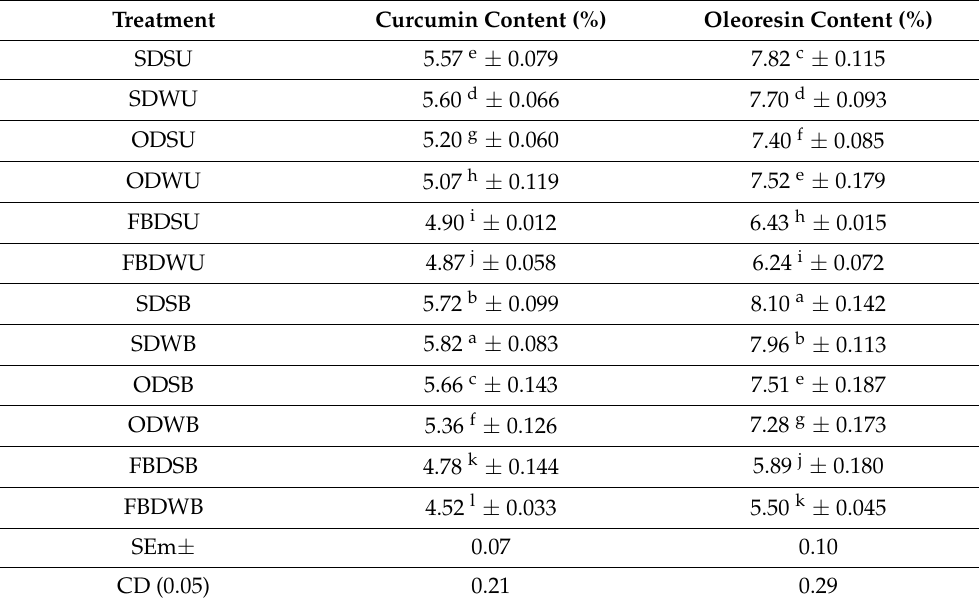
Table 2. Curcumin and oleoresin content of turmeric obtained with different drying methods.